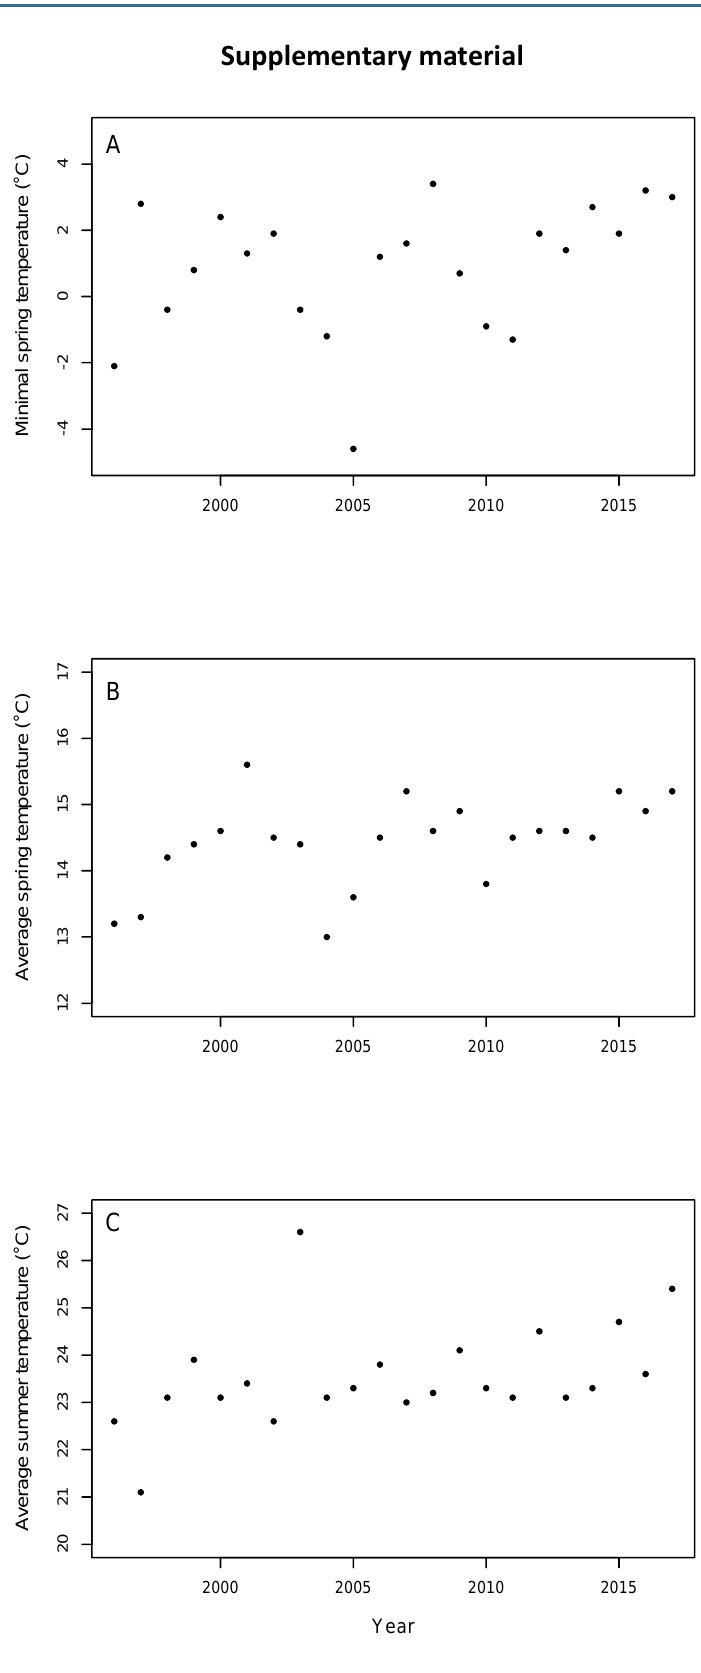
Figure S1. Yearly variation over the 18 years of the study in (A) minimal spring temperature, (B) average spring temperature, and (C) average summer